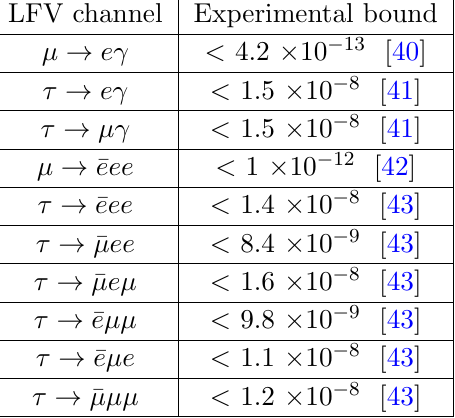
Table 4 . Latest upper limits on LFV branching